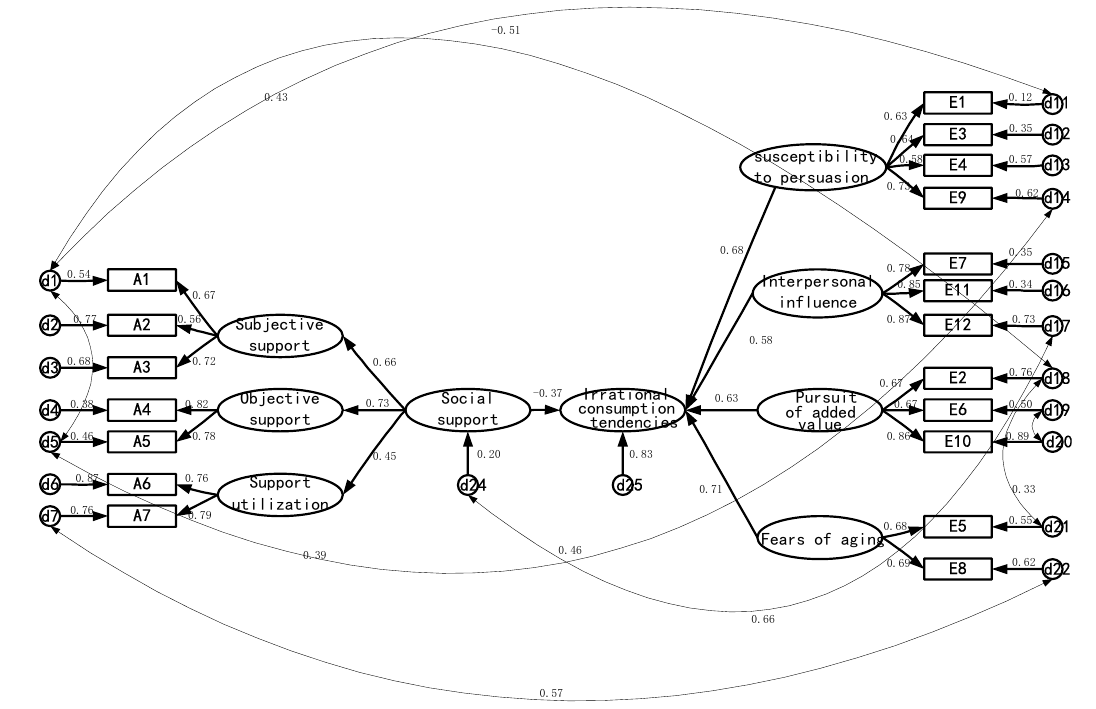
Figure 1. Structural equation model of social support and irrational consumption tendencies. Figure 2 presents the structural equation model with solitary mediating variables. The results show that social support had a significant effect on irrational consumption tendencies (γ = −0.21, p < 0.001), loneliness had a significant effect on irrational consump- tion tendencies (γ = 0.61, p < 0.001), and the consumption effect of social support and lone- liness was significant (γ = −0.26, p < 0.05), indicating that loneliness played a partial medi- ing effect of loneliness accounted for 43%.